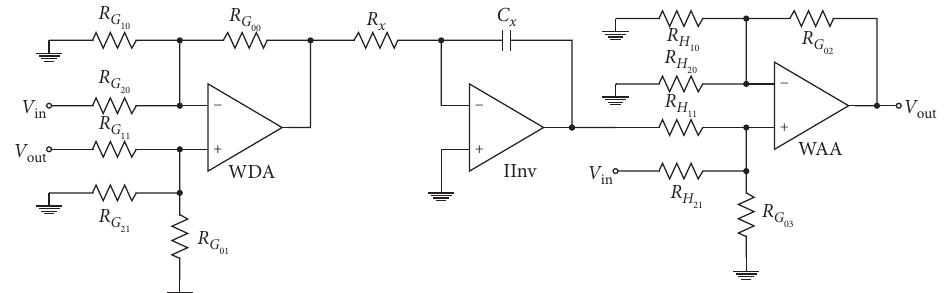
Figure 8: Fractional-order integrator: notation for the sensitivity